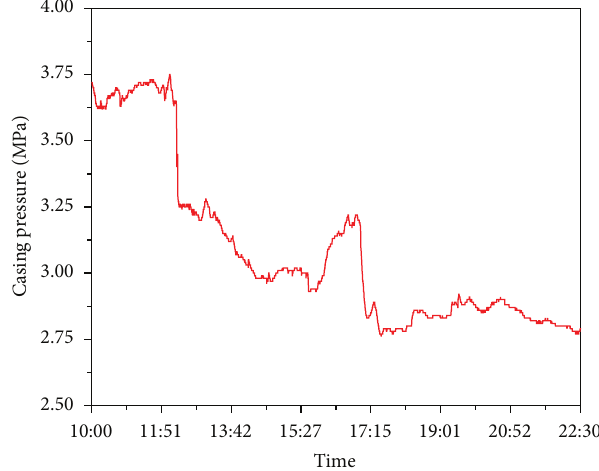
Figure 7: Data acquisition—casing pressure data versus time (2010-